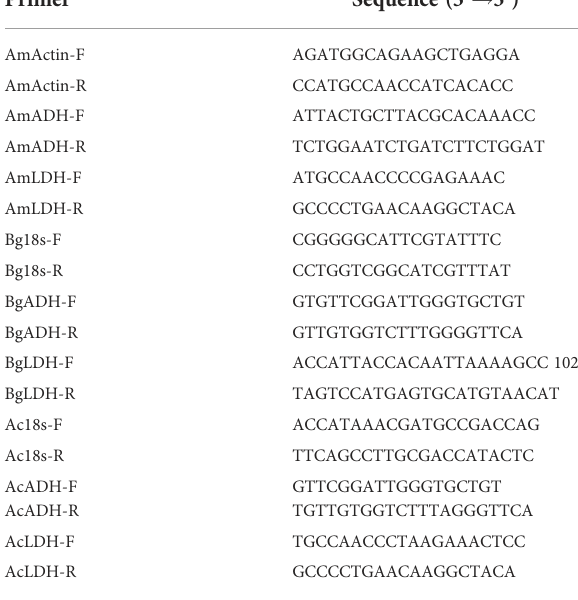
TABLE 2 Primers for